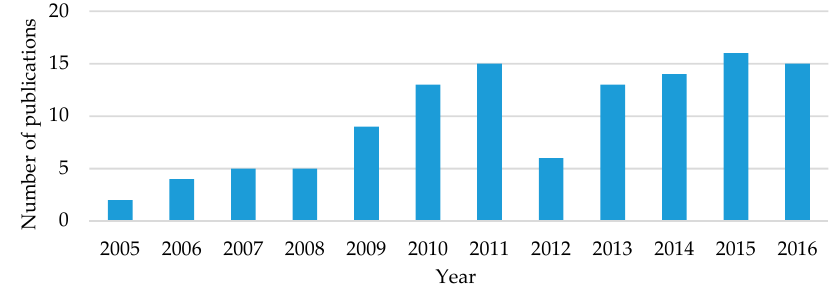
Figure 5. Distribution of publication by year (117 articles).